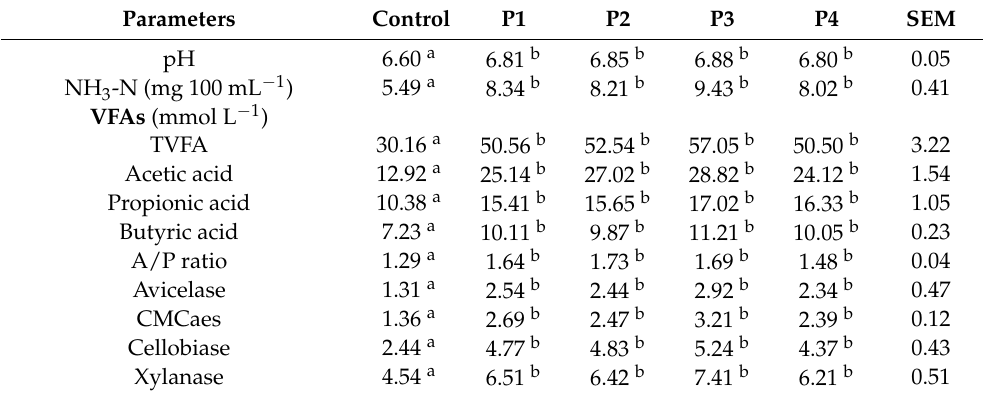
Table 5. The parameters of rumen fermentation of goats fed probiotics in hot summer. Parameters